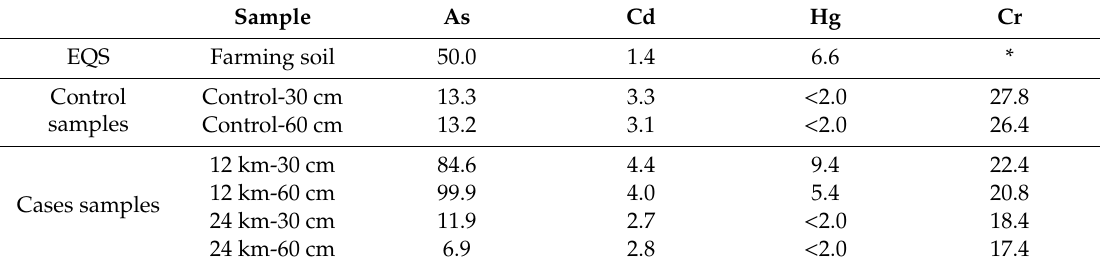
Table 8. Total heavy metal contents (mg kg − 1 ) of soil samples exceeding EQS in the Aimaraes sub-basin.